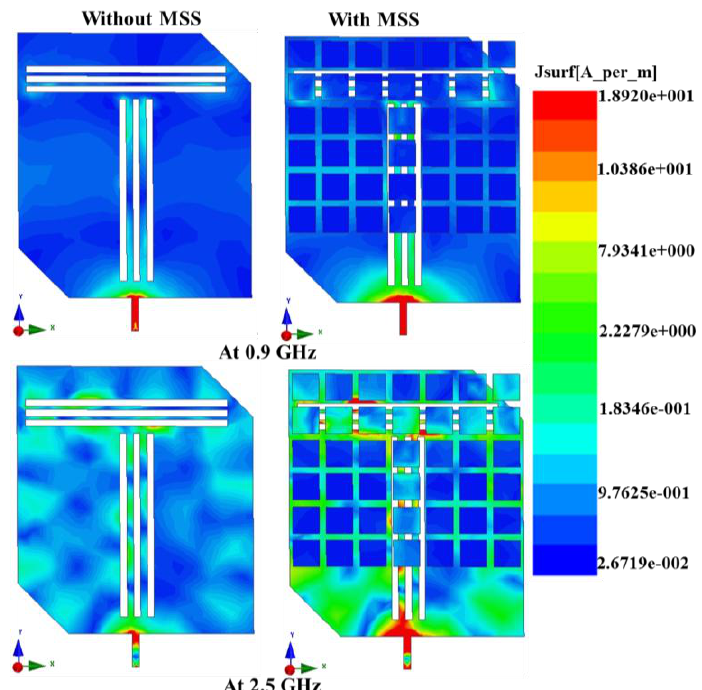
Figure 12. Surface current distribution of the proposed antenna with and without MSS at both lower and upper resonant